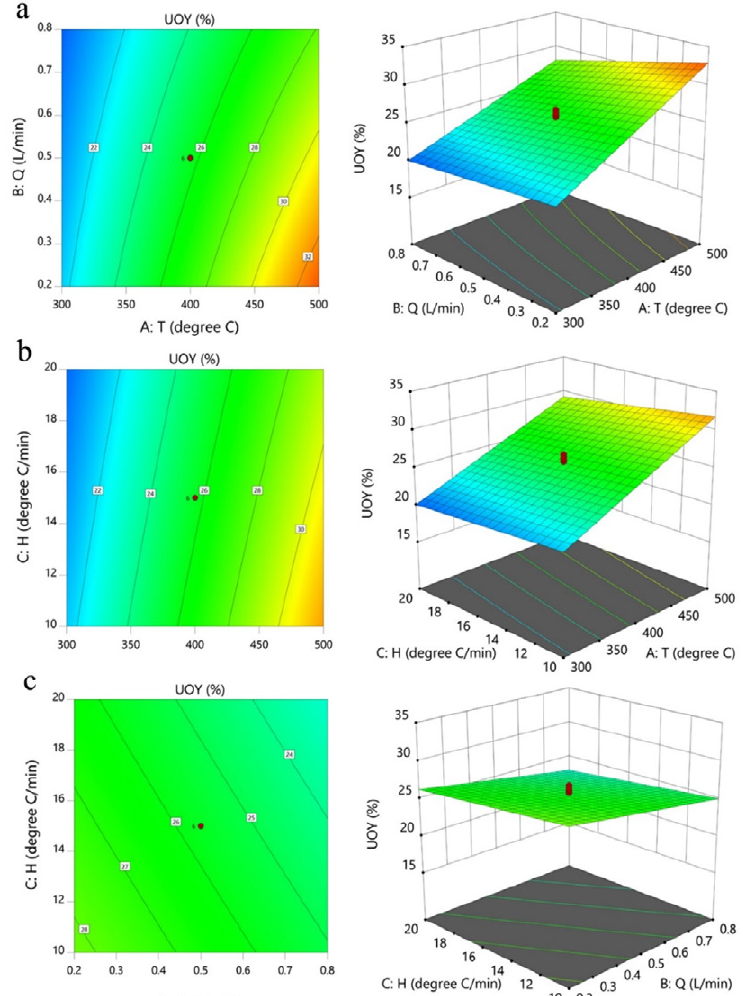
Fig. 3: The contour plots and three-dimensional response surface plots for the bio-oil yield of U. fasciata : (a) temperature versus carrier gas flow rate; (b) temperature versus heating rate; (c) carrier gas flow rate versus heating